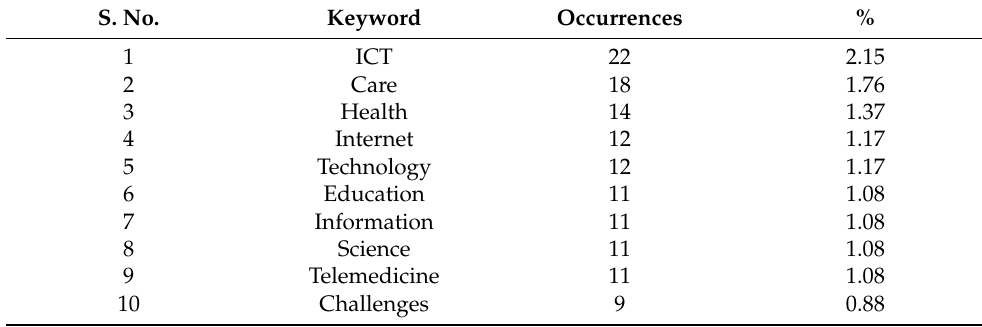
Table 7. Health sciences publications by top ten important